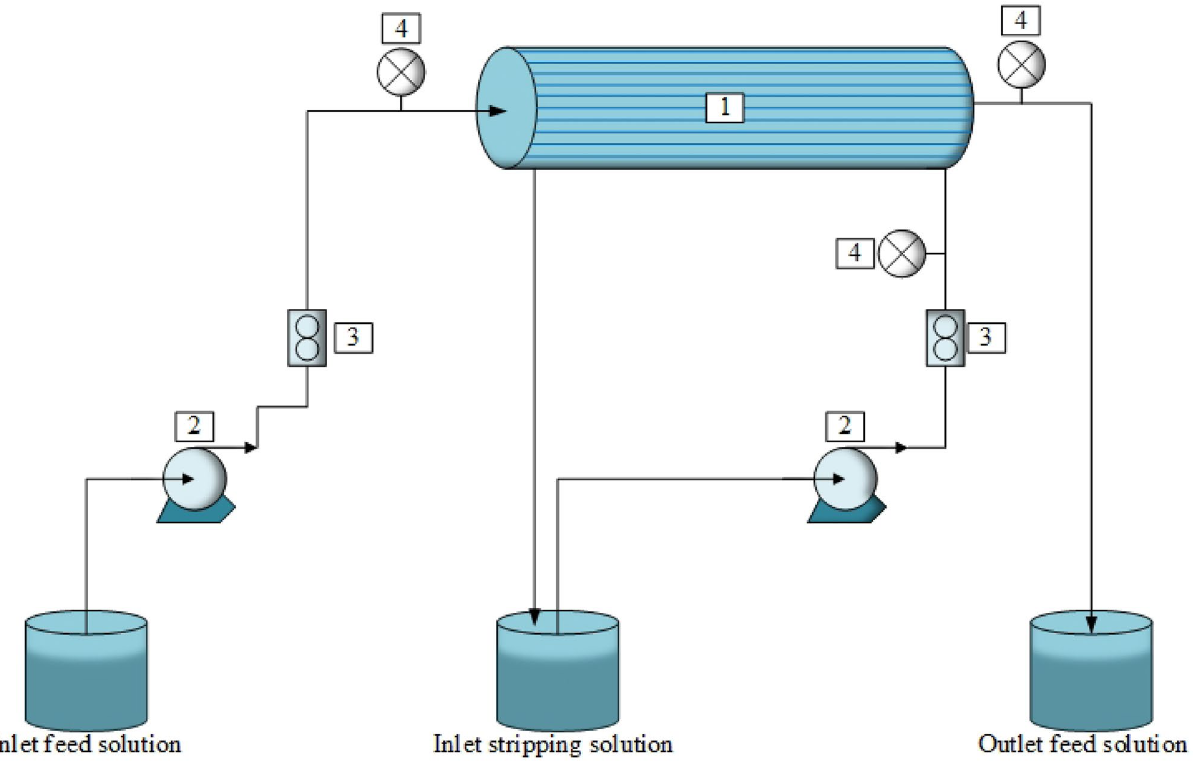
Figure 2. Schema of elimination of arsenic ions via HFSLM: (1) hollow fiber module. (2) Gear pumps. (3) Flow meters. (4) Pressure